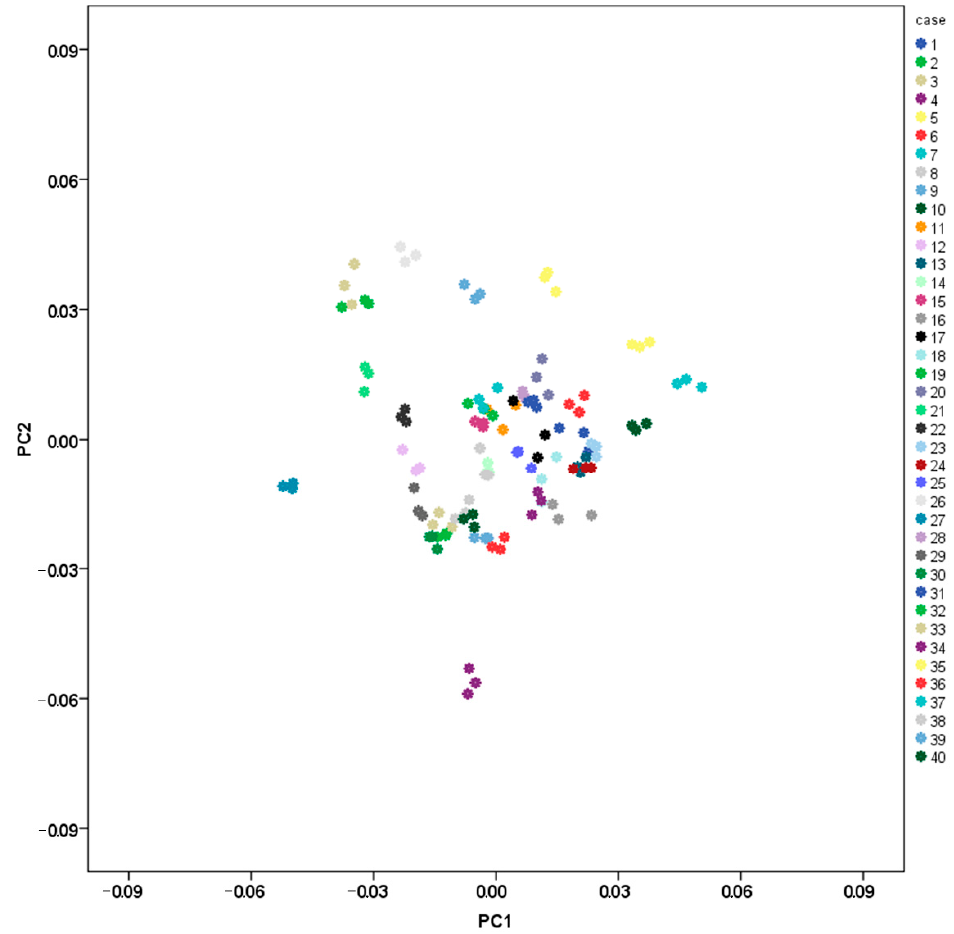
Figure 2. PCA scatterplot: landmark digitization error (three trials of 40 specimens). Table 3. Classification accuracy (in %) based on the centroid